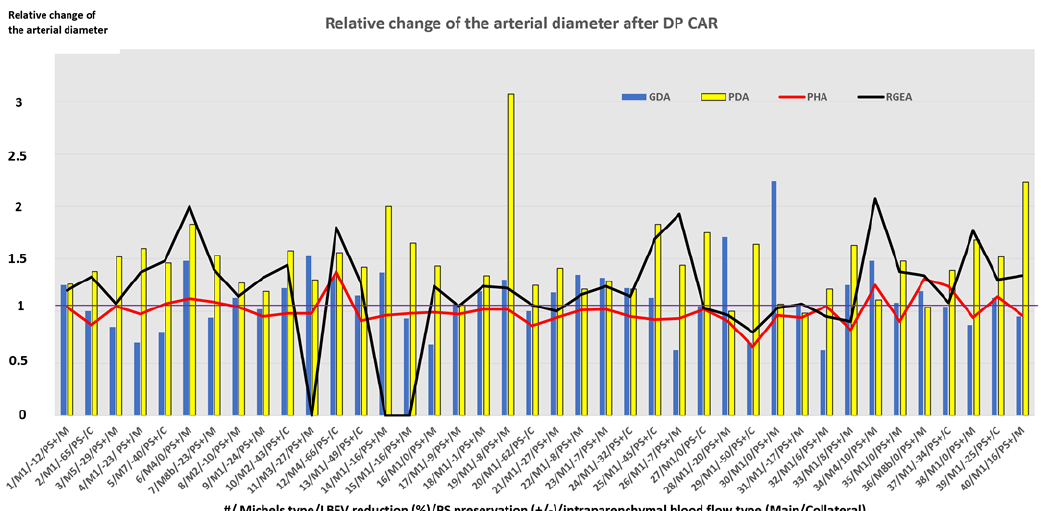
Figure 3. Relative change of the arterial diameter after DP CAR. Along the x-axis, we have Figure 3 . Relative change of the arterial diameter after DP CAR . Along the x-axis, we have the case number (#)/Michels type arterial anatomy (M)/linear blood flow velocity reduction (%)/puls preservation (PS+ or PS − ) on the arteries of the hepatoduodenal ligament/intraparenchymal blood flow type (Main (M) or Collateral C)). Along the y-axis, we have a relative change of the artery diameter (in the number of times). As shown, the diameters of the arteries can increase 2 – 3 times, the gastroduodenal artery can reduce its diameter in some cases, and the diameter of the proper hepatic artery was relatively stable independently on changes of the other arteries’ diameters. The relative change of the arterial diameter values for RGEA and PHA presented here are associated with discrete cases (samples). Straight lines segments connecting these data points were used in the graph in place of bar charts to illustrate the dispersion with regards to the baseline, i.e., the 1.0 value